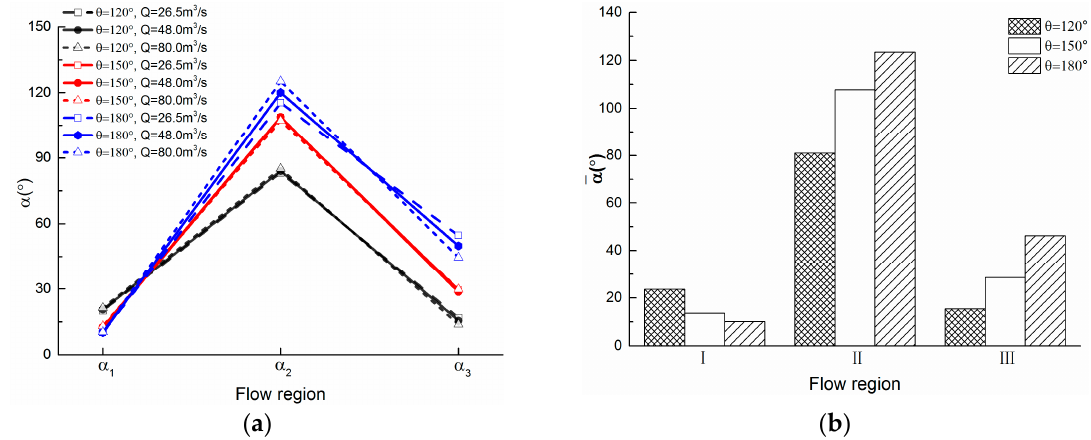
Figure 9. Flow region: ( a ) range of flow regions and ( b ) range of flow regions under different configurations.